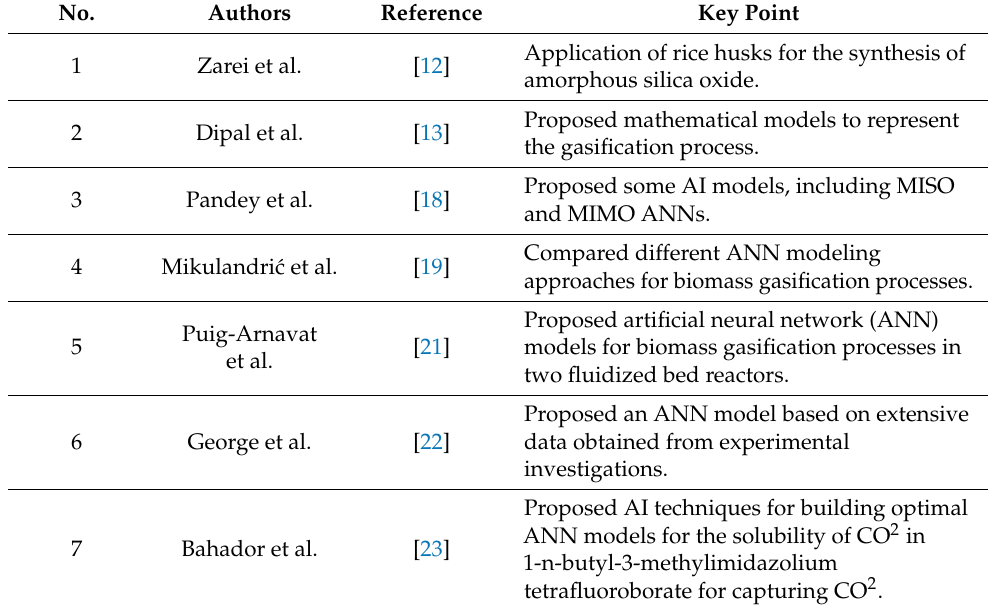
Table 1. Key point of each study in the literature review.